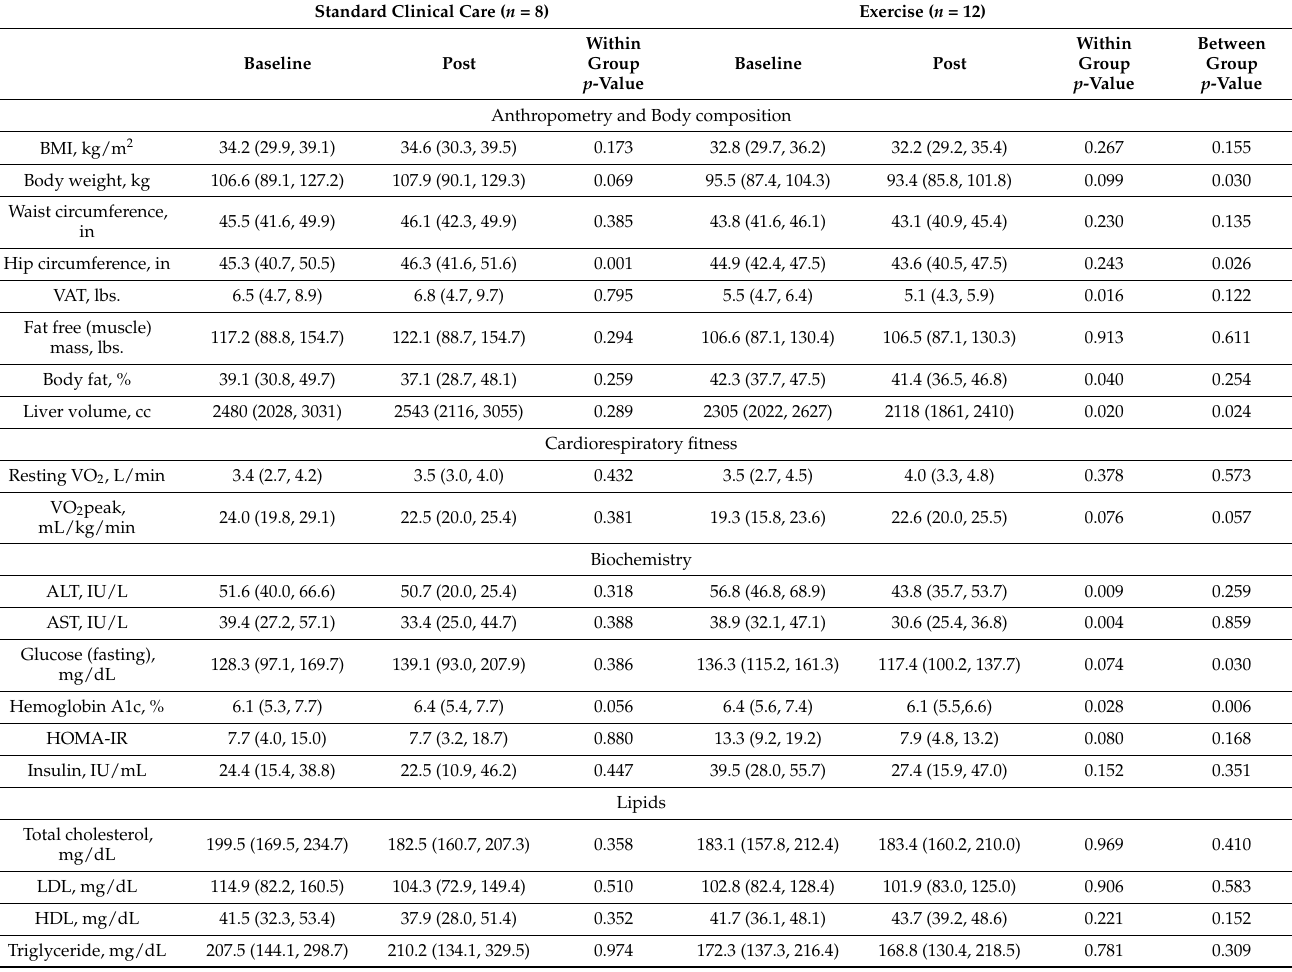
Table 3. Outcome measures: Anthropometry and body composition, fitness, biochemistry and lipids. Standard Clinical Care ( n =